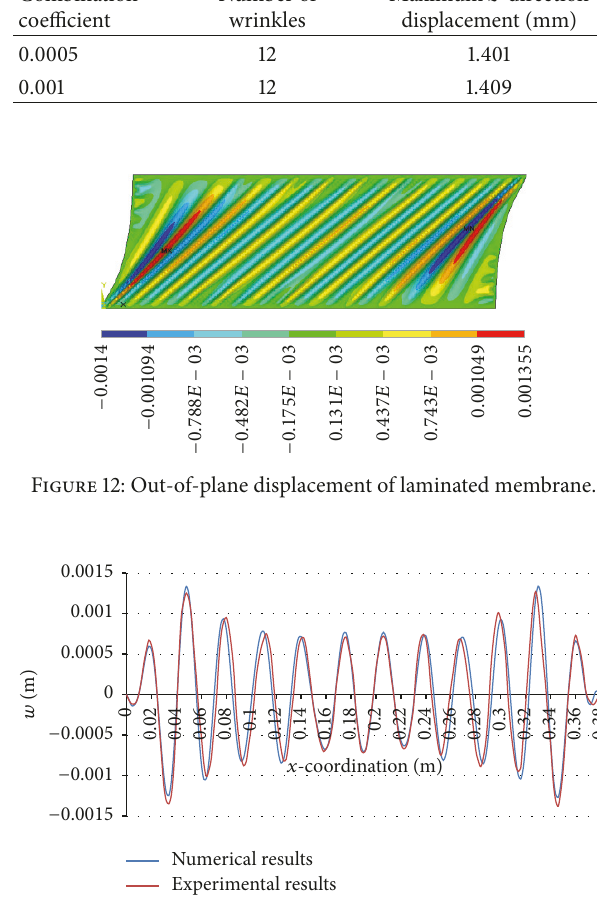
Figure 13: Comparing the results of numerical analysis and test